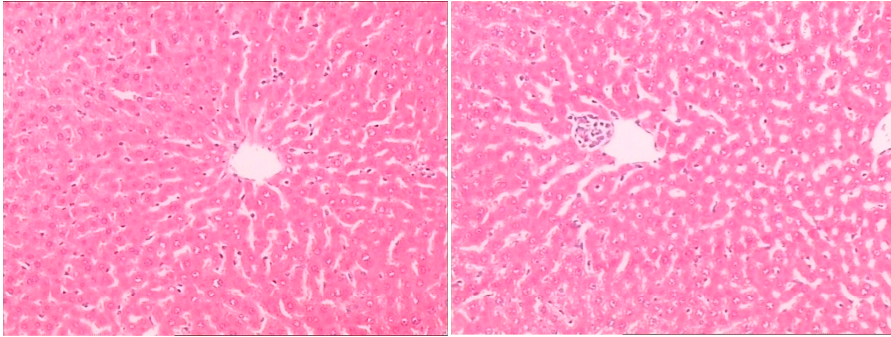
Figure 4. HE-stained histological sections of rat liver in the MG group (Magnification: ×400).